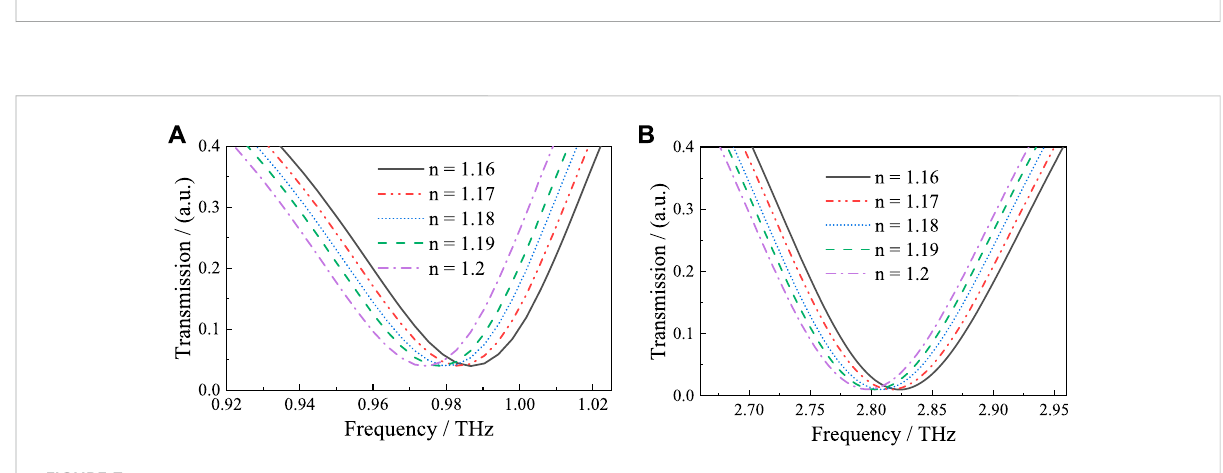
FIGURE 7 ThefrequencyshiftofthetransmissionspectrawithRIchangedfrom1.16to1.2(thechangingstepis0.01)intheresonantmode (A) f 1 and (B) f 2